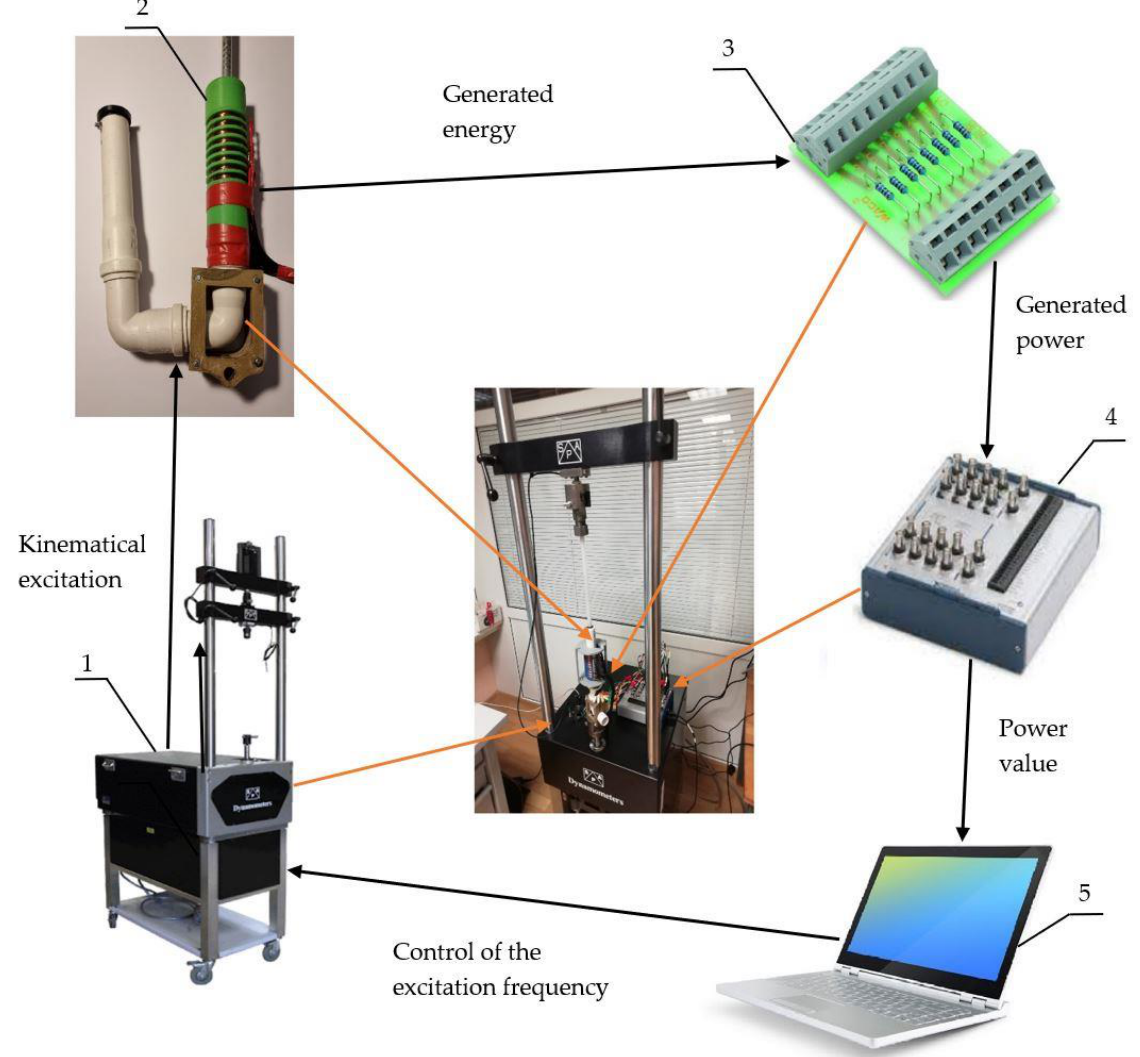
Figure 8 . Schematic view of the experiment rack. 1 — vibration source Dynamometer SPA; 2 — ex- 2—experimental damper; 3—load resistor block; 4—data-acquiring NI-6366 converter; 5—personal perimental damper; 3 — load resistor block; 4 — data-acquiring NI-6366 converter; 5 — personal com- puter for collecting data. computer for collecting